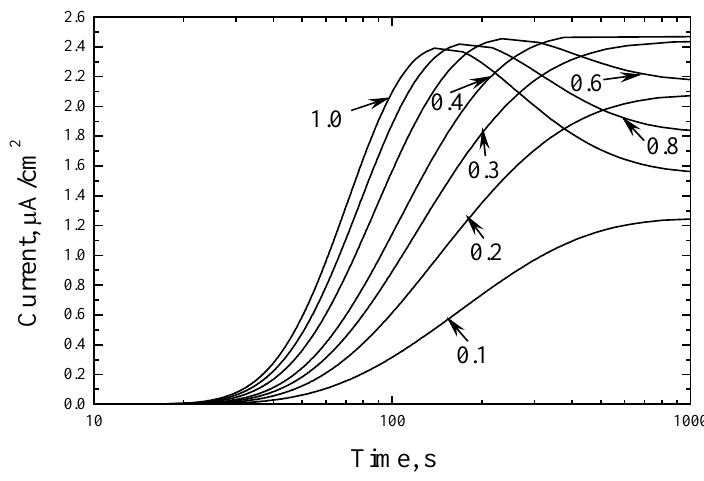
Figure 1 . Kinetics of biosensor response at different values of the normalised substrate concentration. Numbers on the curves show S